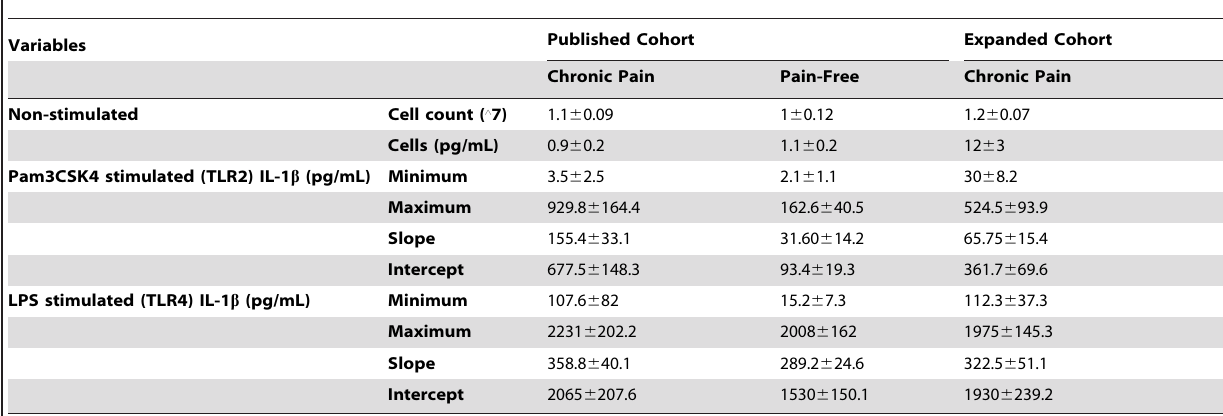
Table 3. Summary of variables collected from humans in the periphery region.